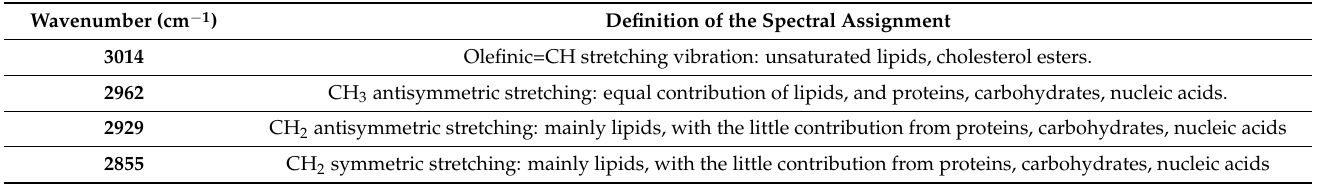
Table 3. General Band Assignment table for Sciatic nerve